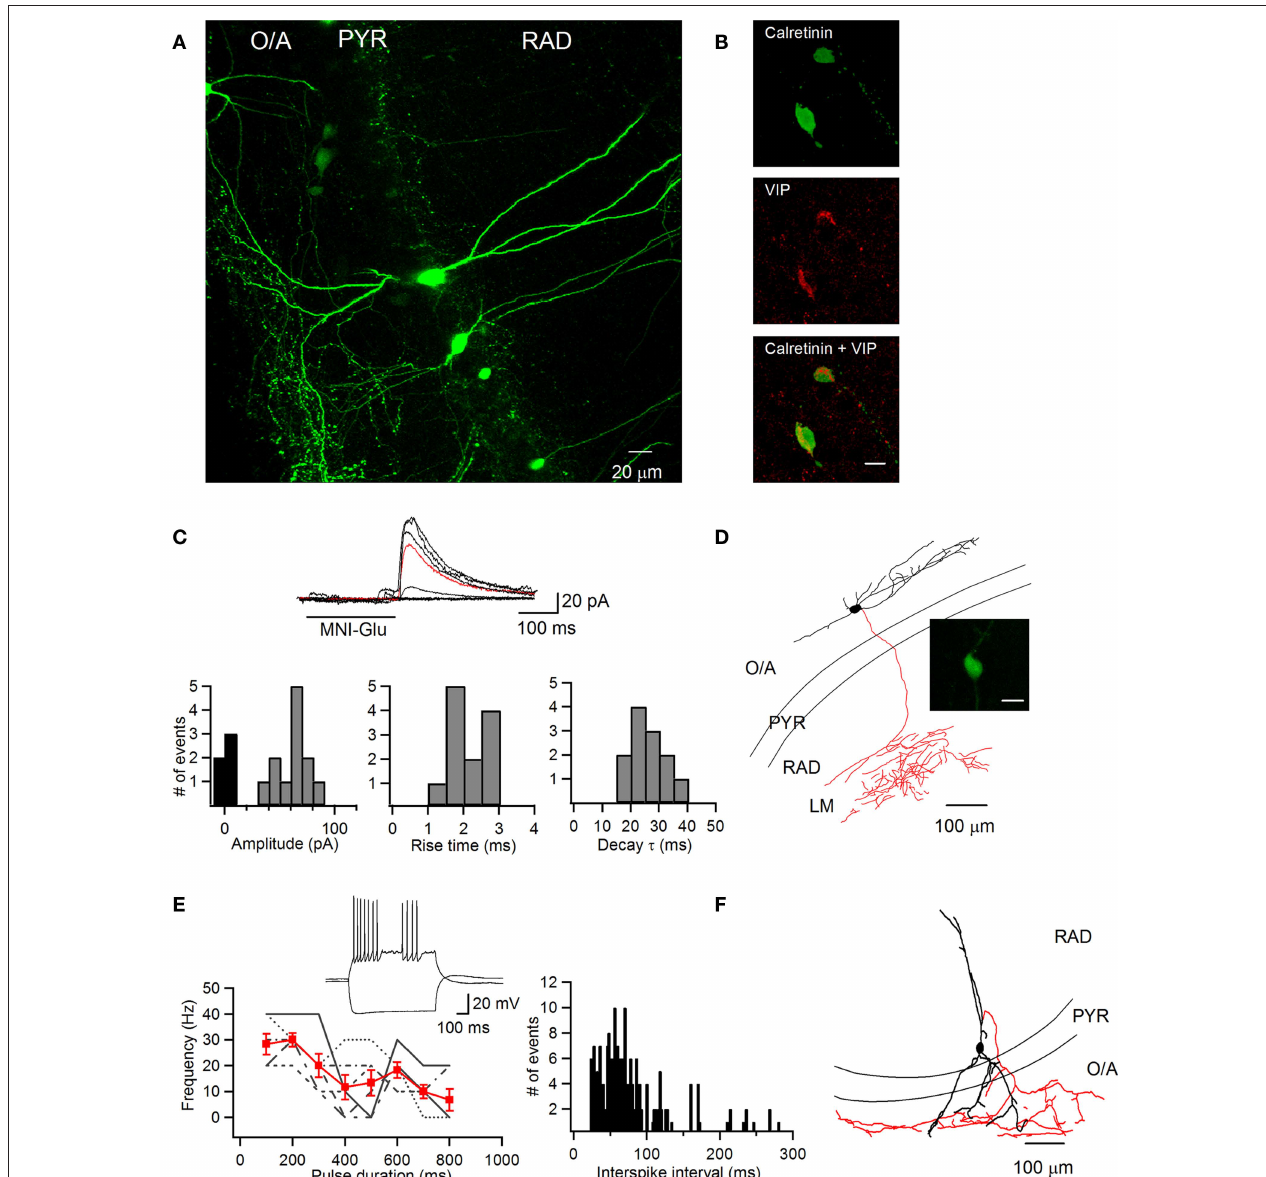
time (middle), and decay time constant (right) from all VIP-positive cells ( n = 4). (D) Neurolucida reconstruction of an O–LM IN from which the recording was obtained (C) . Inset shows a VIP-positive IN, which was stimulated by uncaging. (e) Example of a firing pattern (top) of a VIP-positive IN and a summary plot of firing frequency as a function of pulse duration (bottom left; data from individual cells are shown in black and the group average is shown in red) and interspike interval histogram (bottom right) showing irregularity in IN firing. INs were depolarized to − 40 mV. (F) Reconstruction of a bipolarly oriented VIP-positive cell, showing anatomical features of a putative type III ISI (soma and dendrites are shown in black and its axon is shown in